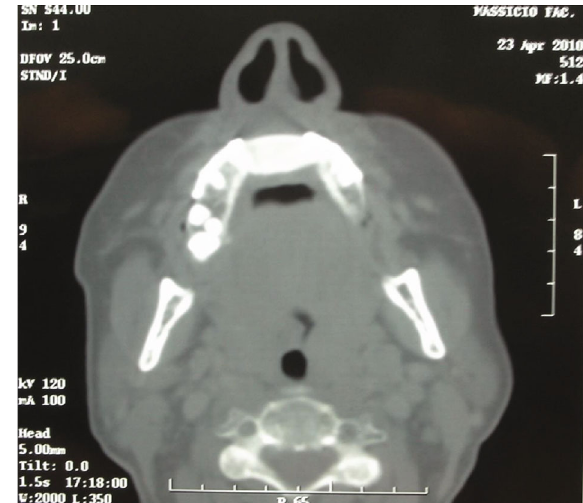
Figure 8: Postoperative CT scan, acquired 5 months after surgery, showing intense radiopacity and good integration of the grafted